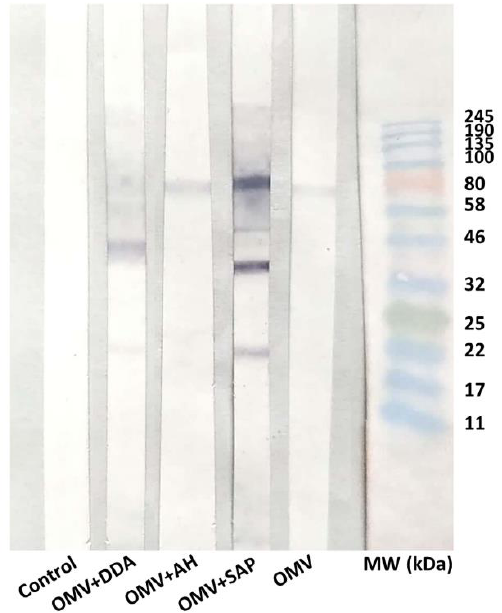
Figure 6. Evaluation of the antigenic recognition by Immunoblot. Sera were collected when mice were young — before the immunization (Control), after two (OMV+AH, OMV+DDA OMV) or